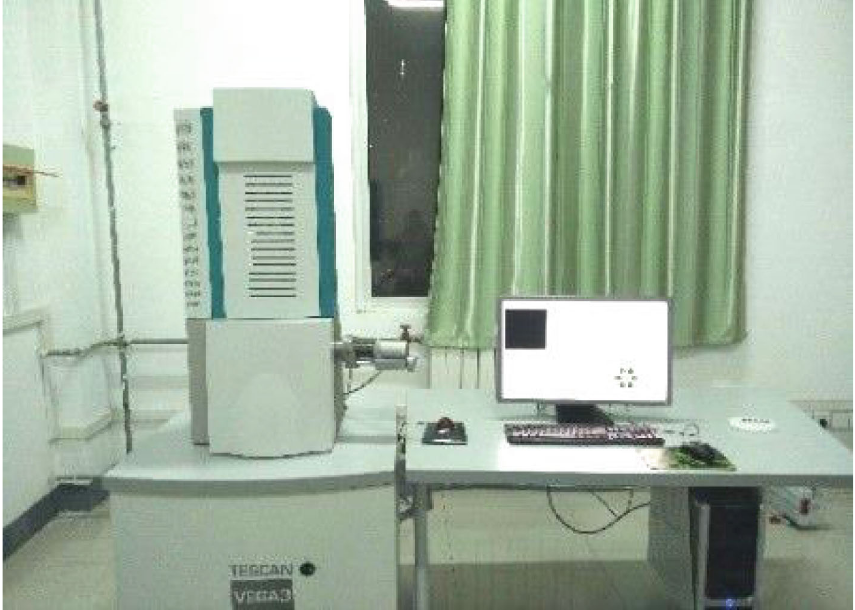
Figure 2: Scanning electron microscope used in SEM analysis.